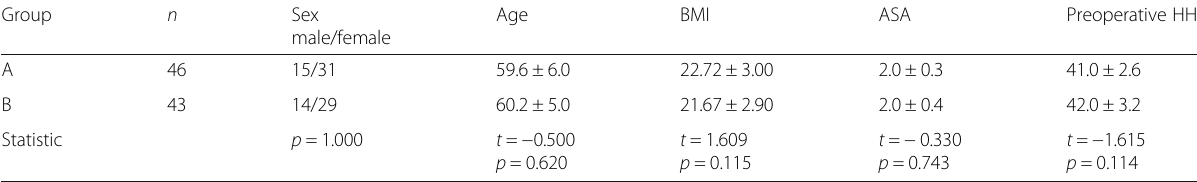
Table 1 Comparison of Patients ’ Demographics ð x (cid:3) s Þ Group n Sex